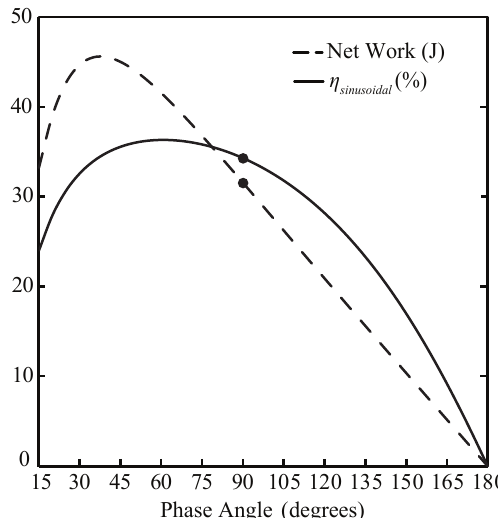
Figure 6. Net work and efficiency as a function of phase angle for an alpha-type Stirling engine. The points indicate the values for the engine details provided in Table 1, with a phase angle of 90 ◦ .